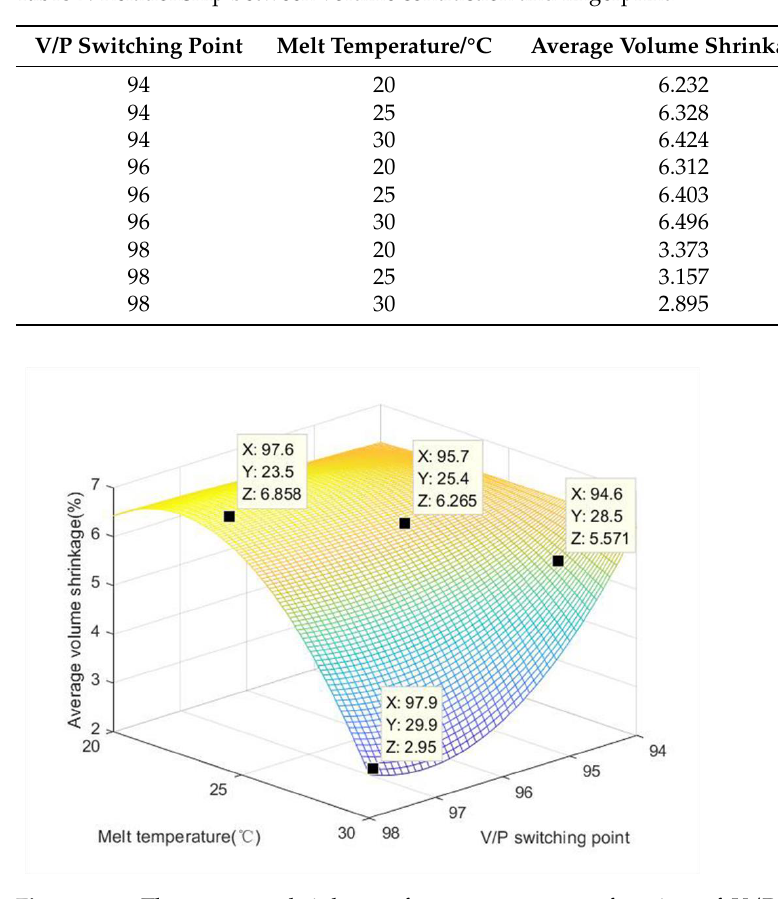
Figure 13. The average shrinkage of components as a function of V/P switching point and melt temperature.